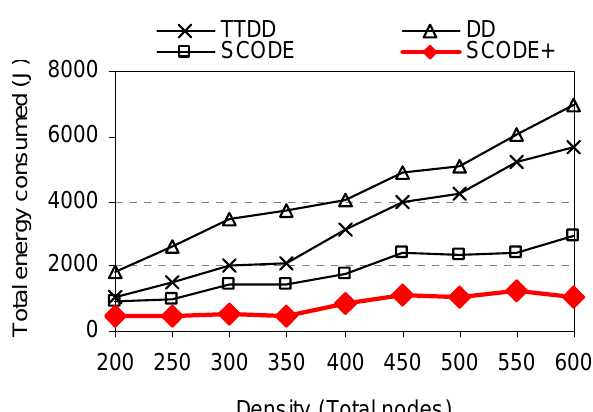
Figure 15. Energy consumption vs. sink